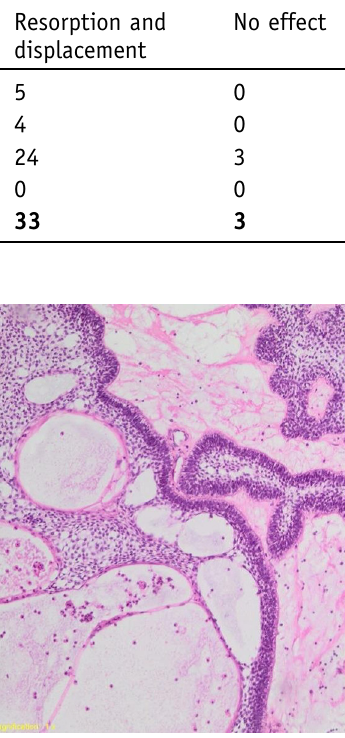
Fig. 6. Scatterplot of size versus age in patients with ameloblastoma.